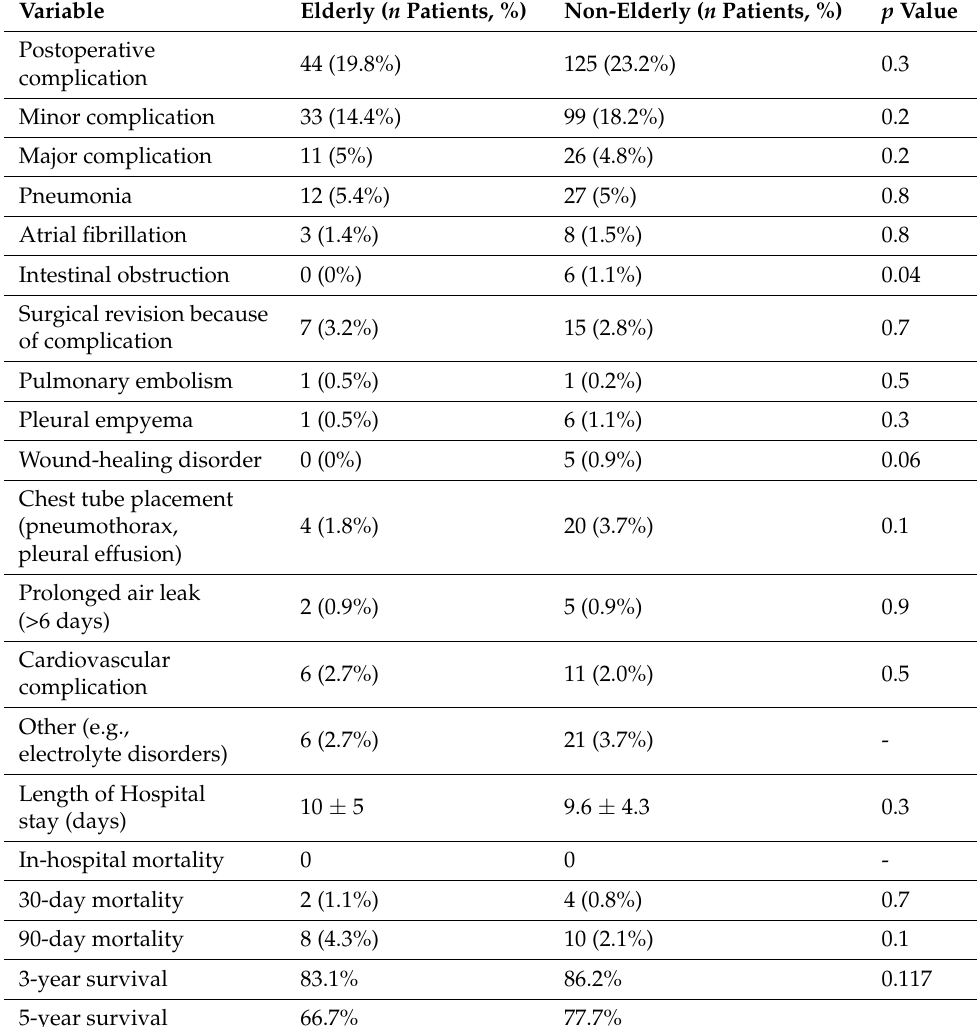
Table 4. Morbidity and mortality in elderly patients and in patients aged < 70